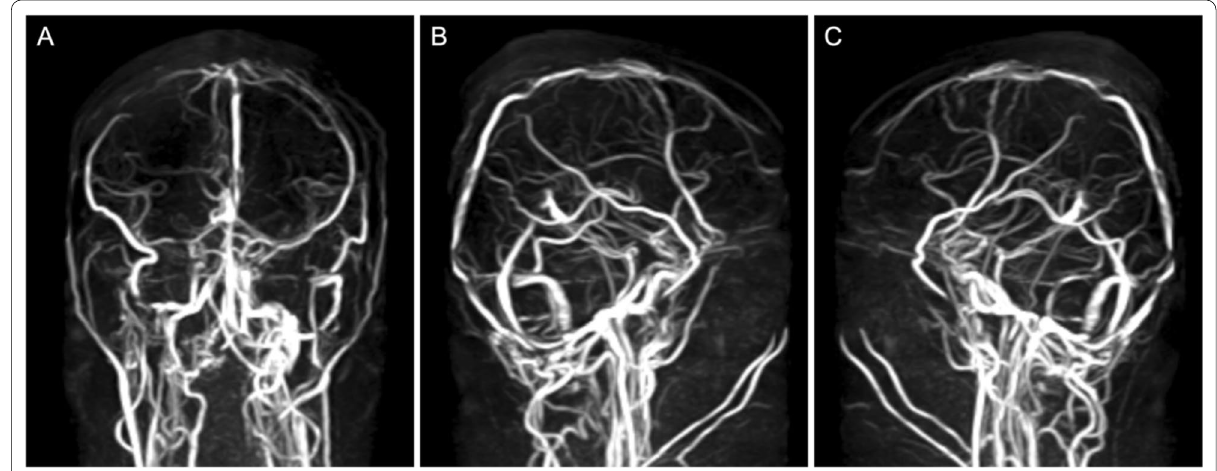
Fig. 2 Follow-up head MRV conducted 4 weeks later revealed improvement of thrombosis, with restoration of flow in the superior sagittal sinus ( A – C